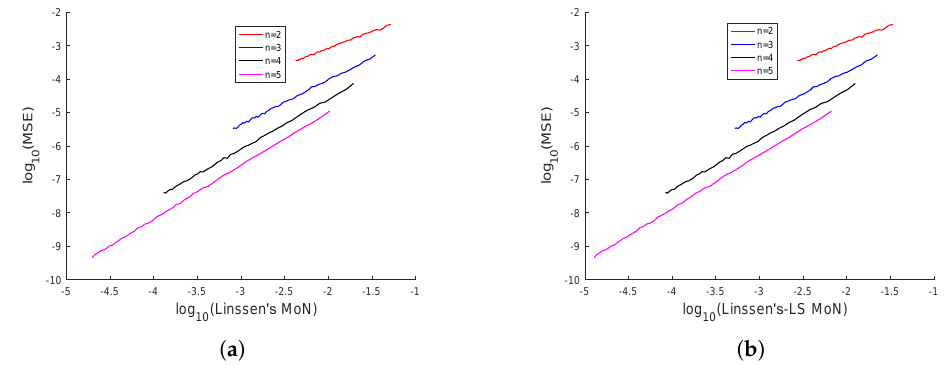
Figure 15. ( a ) log 10 scalar